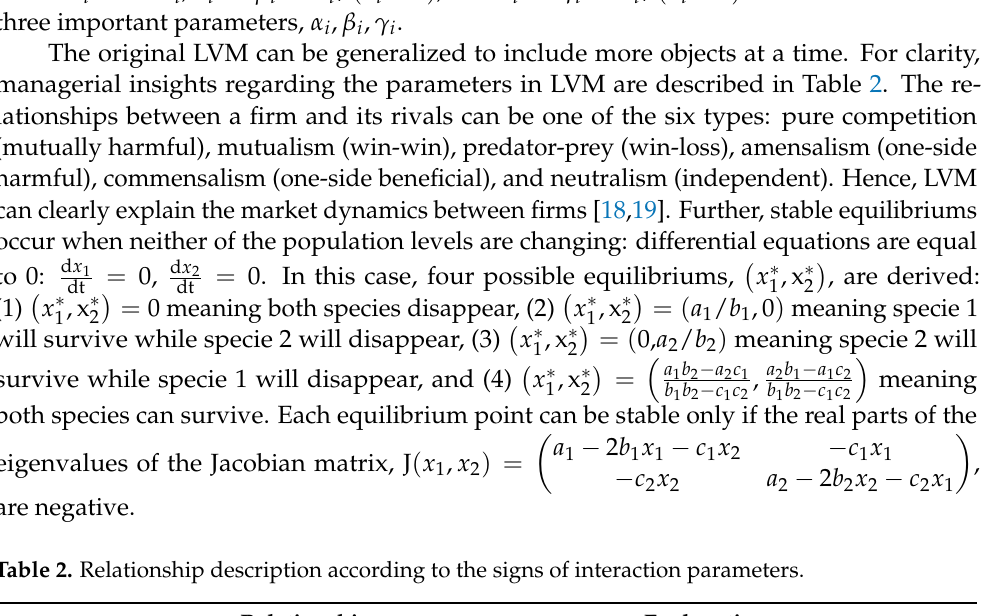
Table 2. Relationship description according to the signs of interaction parameters. c 1 , c 2 Relationship Explanation +, + Pure competition Both suffer from each other’s existence +, − Predator-prey Entity 1 serves as direct food to entity 2 − , − Mutualism The case of symbiosis (win-win) Entity 1 suffers from the existence of entity 2, who is +, 0 Amensalism impervious to what is happening Entity 1 benefits from the existence of entity 2, who − , 0 Commensalism nevertheless remains unaffected 0, 0 Neutralism No interaction between each